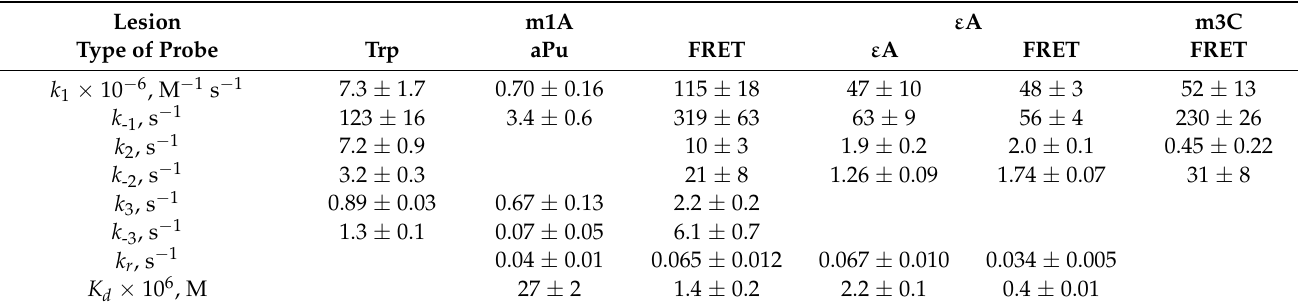
Table 2. A summary of kinetic parameters for DNA dealkylation by the ALKBH2 protein, as determined by global